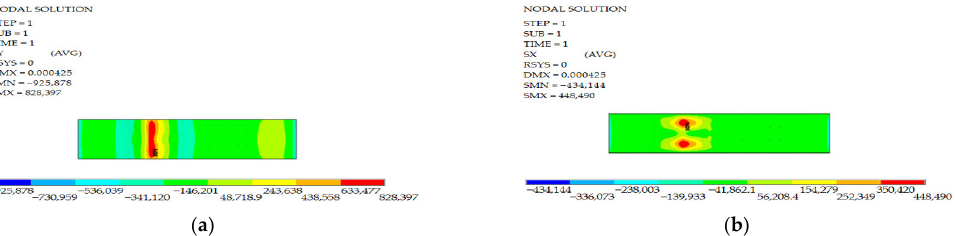
Figure 20. Stress distribution diagram of the base plate under 15 million applications of fatigue load (working condition 2). ( a ) Longitudinal stress of base plate; ( b ) lateral stress of base plate.